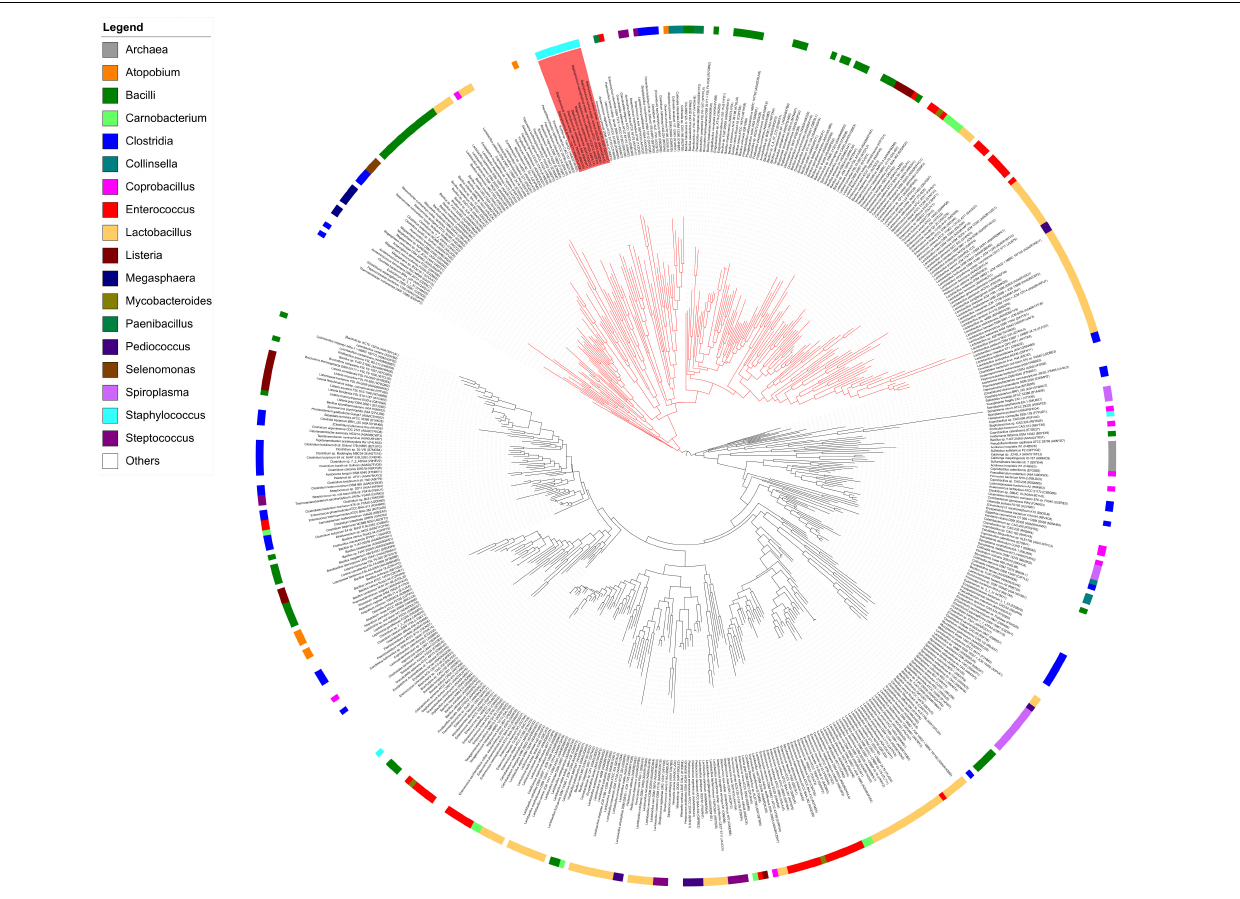
FIGURE 8 | Phylogenetic tree showing the relation of MupG orthologs. The phylogenetic tree was constructed with RaxML from an alignment of 519 amino acid sequences, based on the Pfam entry PF05913, which lists putative orthologs of MupG (DUF871 domain proteins). The genus of Staphylococcus is marked by a red rectangle and includes MupG of S. aureus USA300, which was characterized in this study as a MurNAc 6P-glycosidase. Putative MurNAc 6P glycosidase (close orthologs of MupG) constitute a distinct clade, indicated by red lines. More distantly related MupG-like proteins constitute different clades that are indicated by black lines. Bacterial genera are color coded as indicated. See Supplementary Table 3 for a complete list of the proteins within this phylogenetic